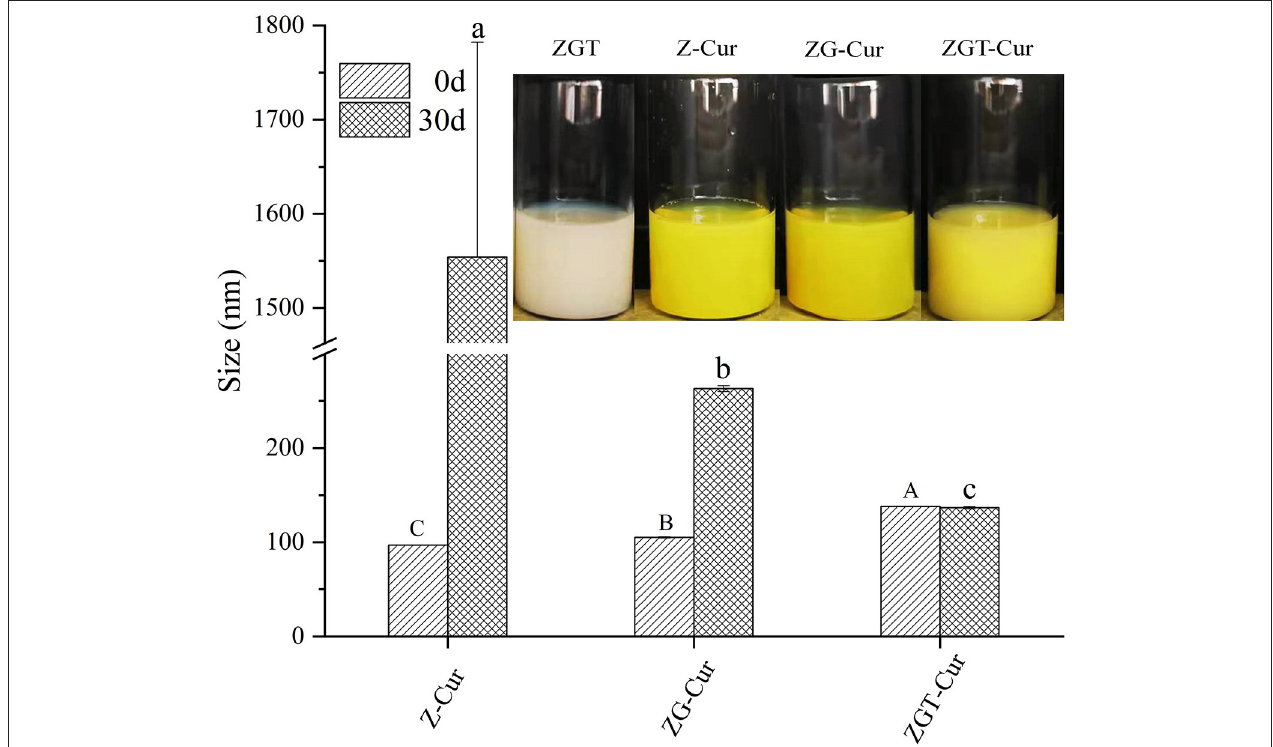
FIGURE 5 | Effect of different storage times (0 and 30 days) on composite particle size.